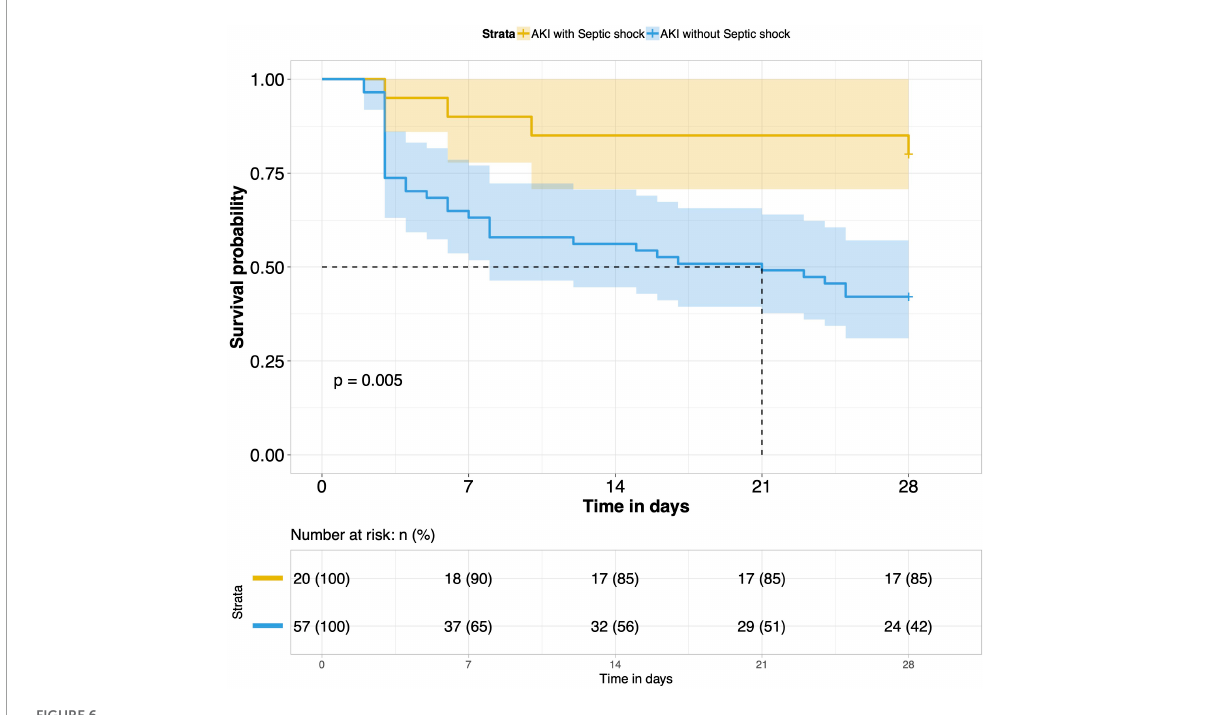
FIGURE6 Survival analysis of AKI with septic shock group and AKI without septic shock group.